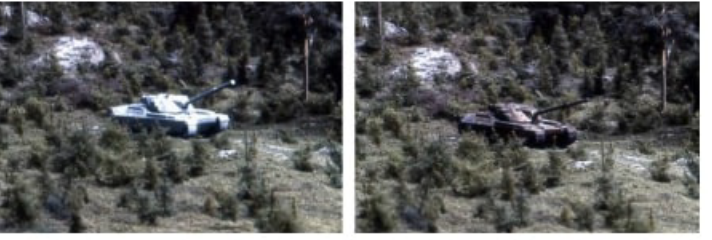
Figure 1. Example of color camouflage—a tank without camouflage on the left , camouflage on the right [6].